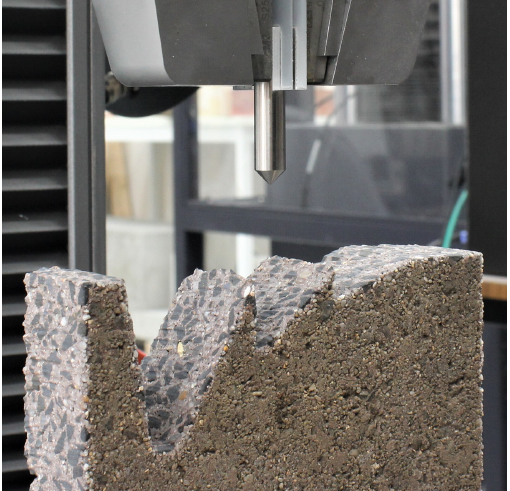
Figure 5. Angled tip with a = 1, b = 1, n = 1 Figure 4. A photo of the Instron driving a tip against